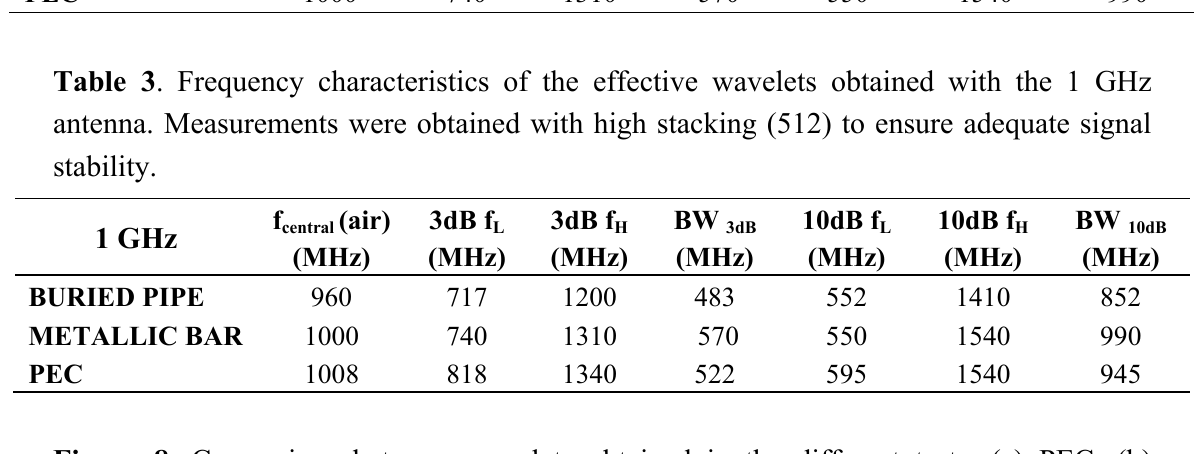
Figure 8 . Comparison between wavelets obtained in the different tests. (a) PEC. (b) Metallic bar. (c) Buried Pipe. (Emitted wavelets of a 500 MHz antenna obtained in a previous work are also show for